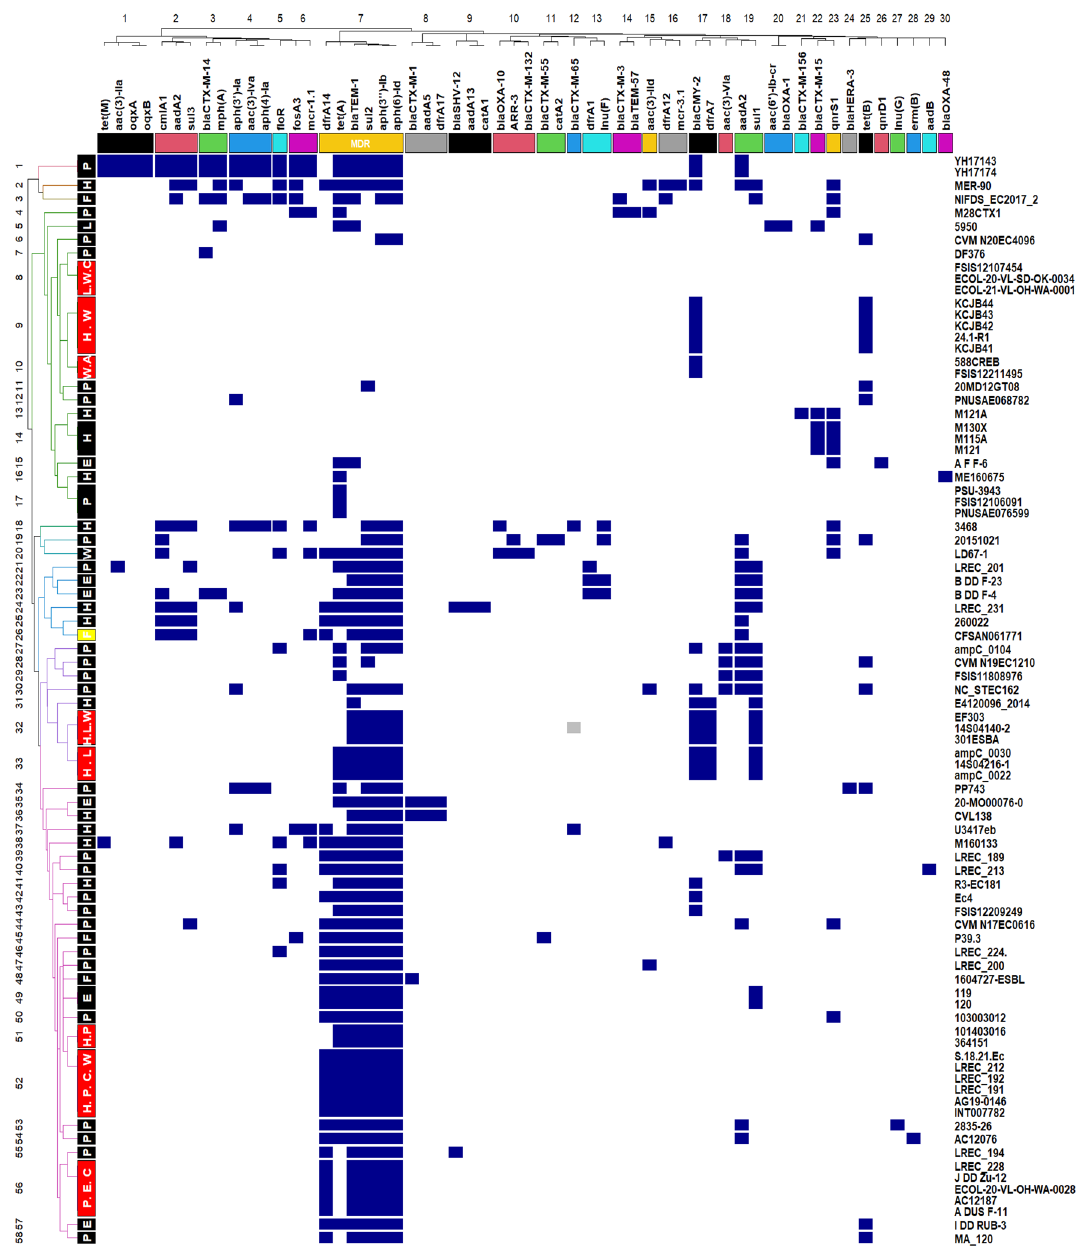
Figure 7. Heat map demonstrating the distribution of antibiotic resistance genes in E. coli ST1485 strains. Blue represents the presence and white represents the absence of a virulence gene. Strains from various origins with identical virulence profiles were denoted as red squares on the left, whereas strains from the same source were denoted as black squares. The yellow square denotes the sequenced reference strain CFSAN061771. H human, L livestock, P poultry, C companion animals, W wild animals, F food, A aquatic